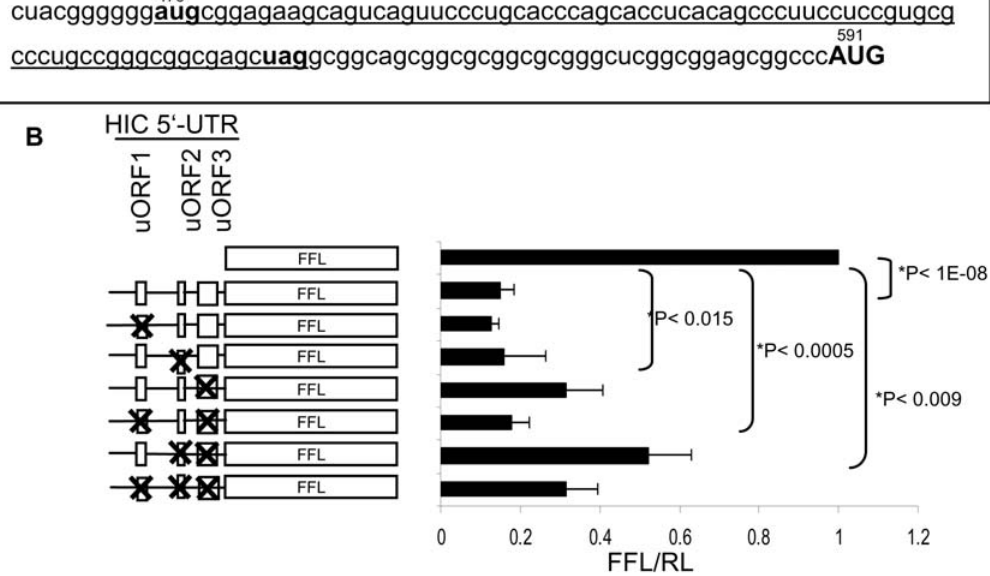
Figure 4. Mutations in the uORFs diminish the inhibitory effect of HIC 5 9 -UTR on FFL activity. A. Sequence of HIC 5 9 -UTR. Initiation and termination codons of the uORF are indicated in bold. uORFs are underlined. The HIC protein initiating codon is indicated by capital letters. Numbers denote the nucleotide number according to Genebank NM 199072 HIC cDNA sequence. B. A schematic representation of constructs expressing a FFL reporter gene, HIC-5 9 -UTR fused to the FFL gene, or HIC-5 9 -UTR-FFL in which one or more of the three uORF initiation codons were mutated to an AUC codon (left panel). Constructs were expressed in Saos2 cells together with a plasmid encoding Renilla luciferase as a control for transfection efficiency. Cells were harvested 24 h post transfection and dual luciferase activities measured. FFL activity values were normalized to RL. The presented values are the average of four independent experiments preformed in duplicate.